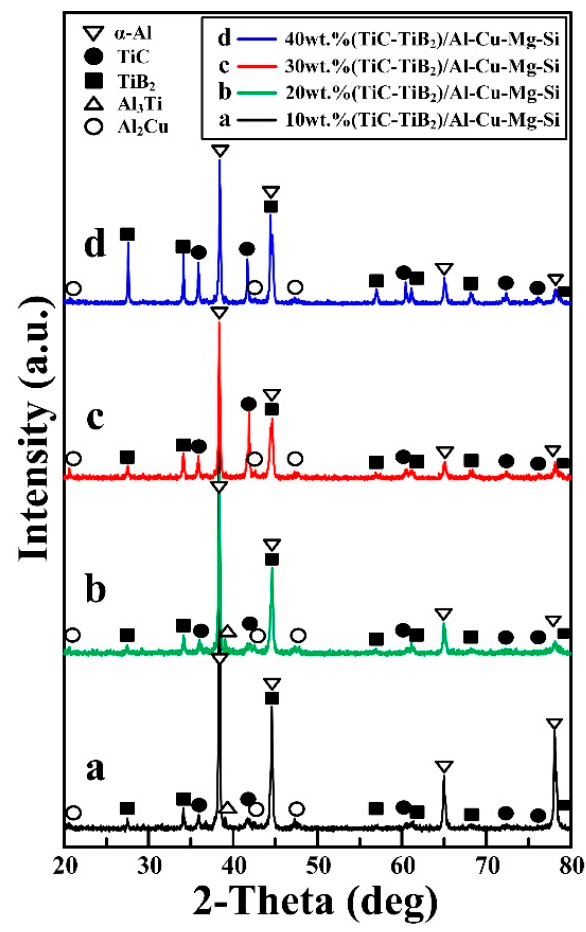
Figure 3. XRD patterns of prepared (TiC-TiB 2 )/Al-Cu-Mg-Si composites with different TiC-TiB 2 particle content.